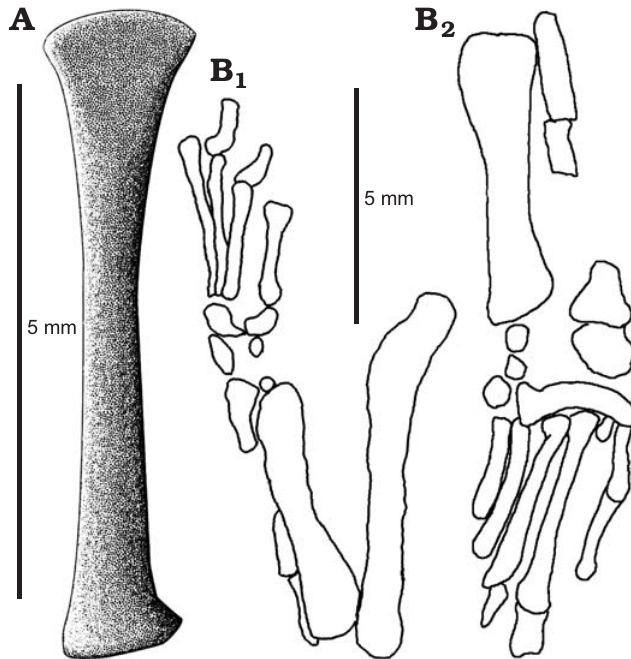
Fig. 9. Hindlimb of Slavoia darevskii . A . Based on ZPAL MgR-I/9, tibia in ventral view. B . Based on PIN 3142/358, outlines of hindlimb in dorsal (B 1 ) and anterior (B 2 ) views.